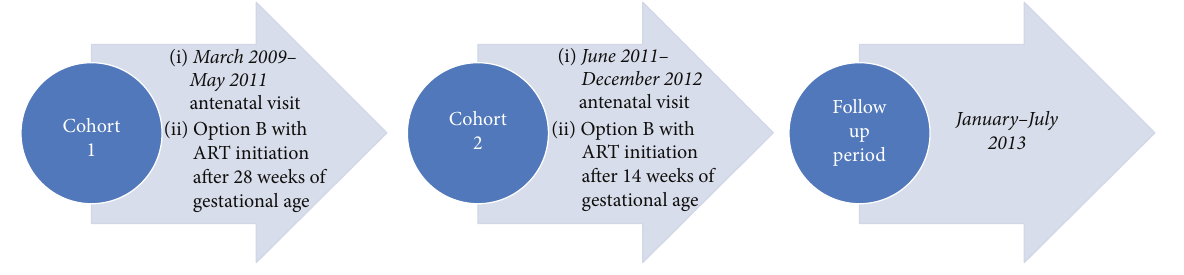
Figure 1: Study timeline for HIV-infected pregnant